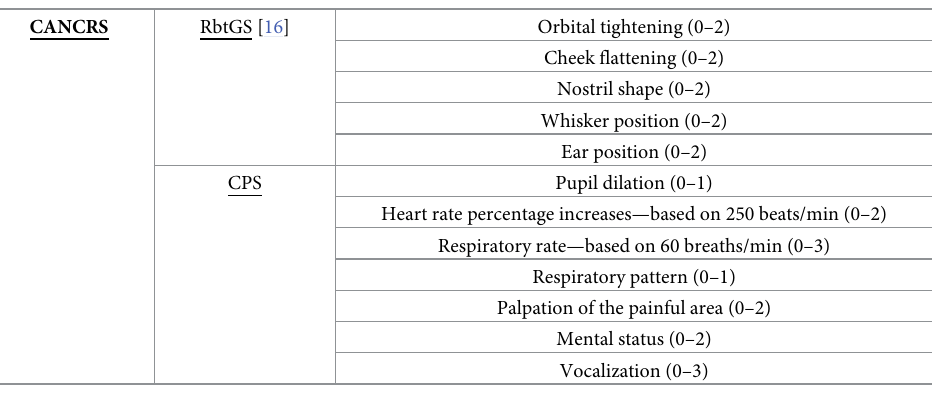
CANCRS includes the five Facial Action Units (FAU) of the RbtGS [15] and some clinical parameters gathered in the CPS. For each parameter, two to four scores were possible. The final score is the total sum of the ones given to each parameter.